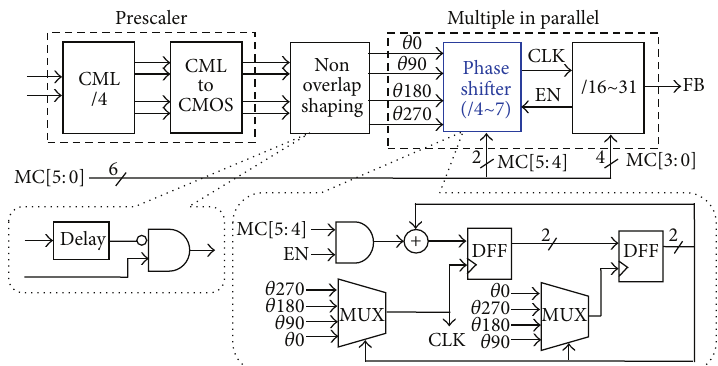
Figure 10: PS-based MMD module.